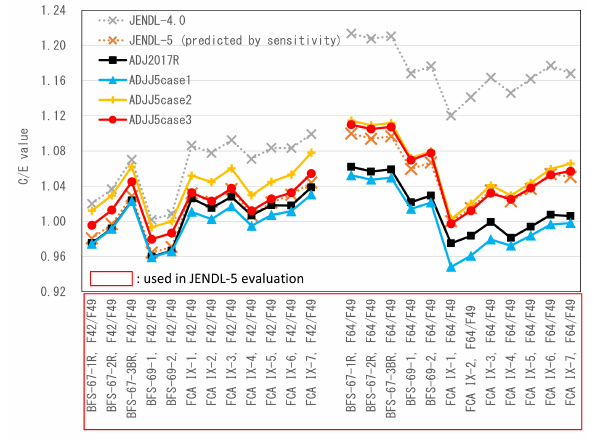
Figure 3. C / E values of reaction rate ratio of F42 / F49 and F64 / F49